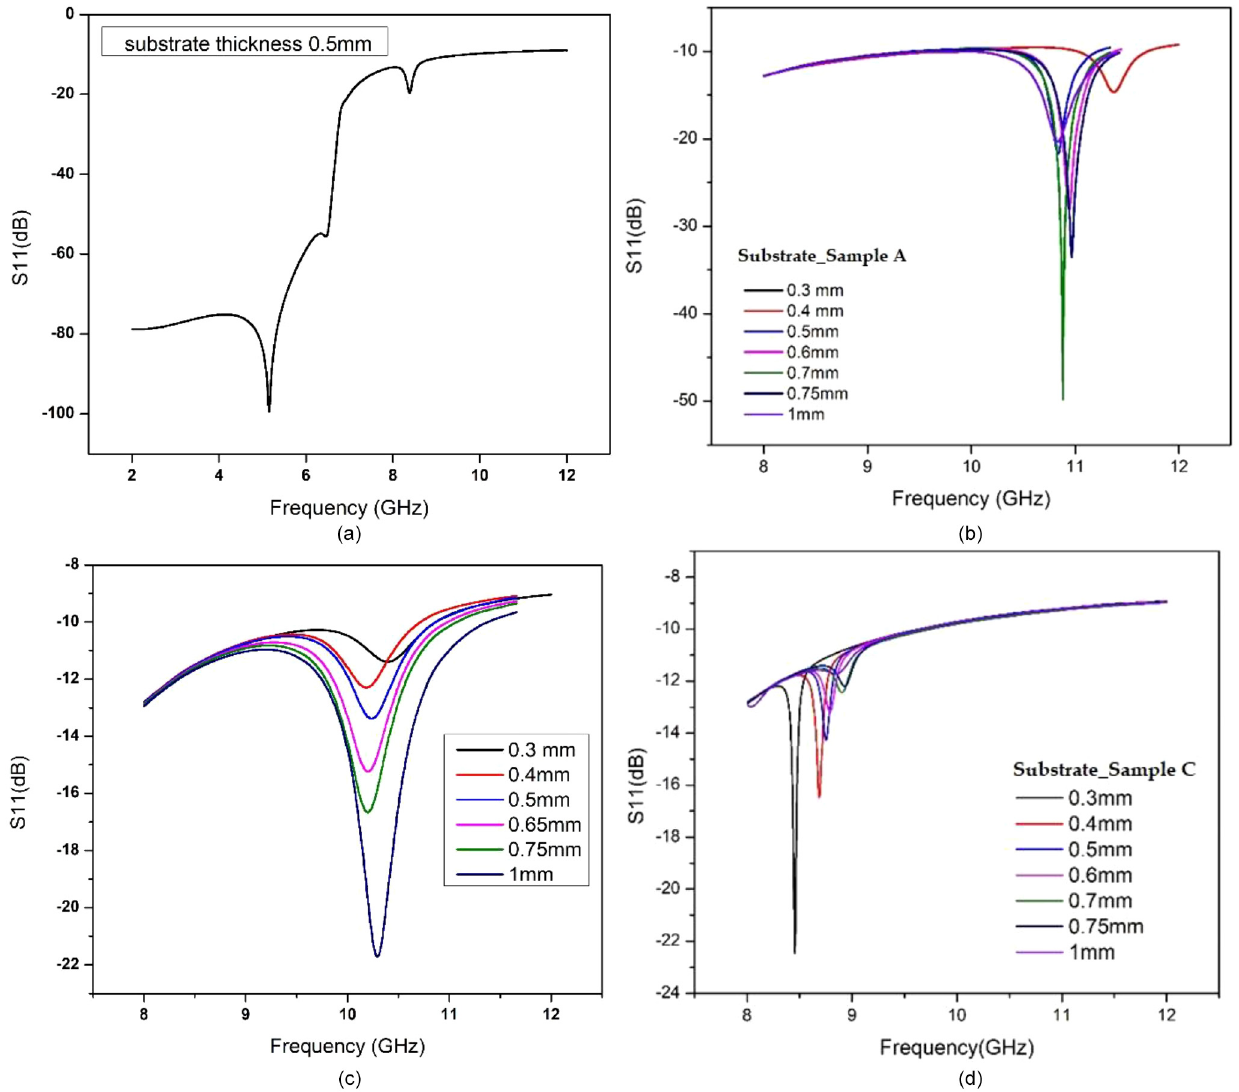
Fig. 5. Simulated S11 ( v ) values of the proposed MA design on (a) FR4, (b) Sample A, (c) Sample B, (d) Sample C